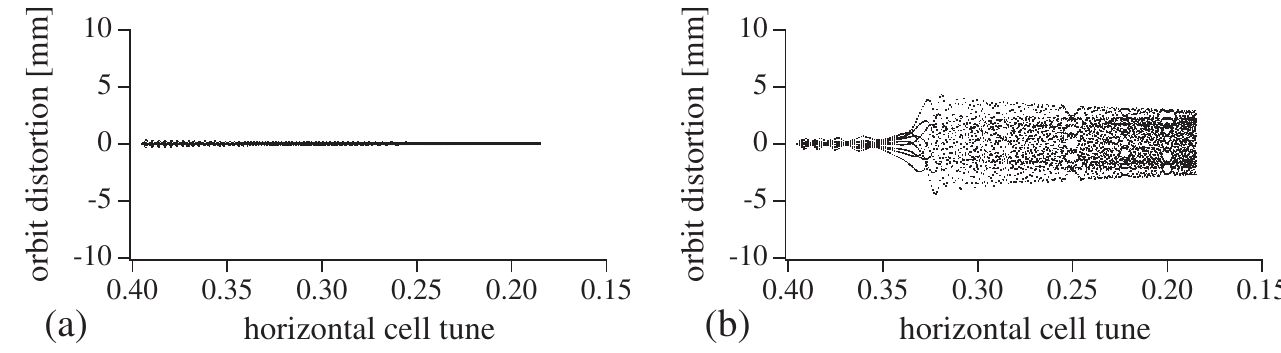
FIG. 2. Horizontal orbit distortion with different number of rf cavities. rf cavities are installed every (a) 2 and (b) 3 cells.